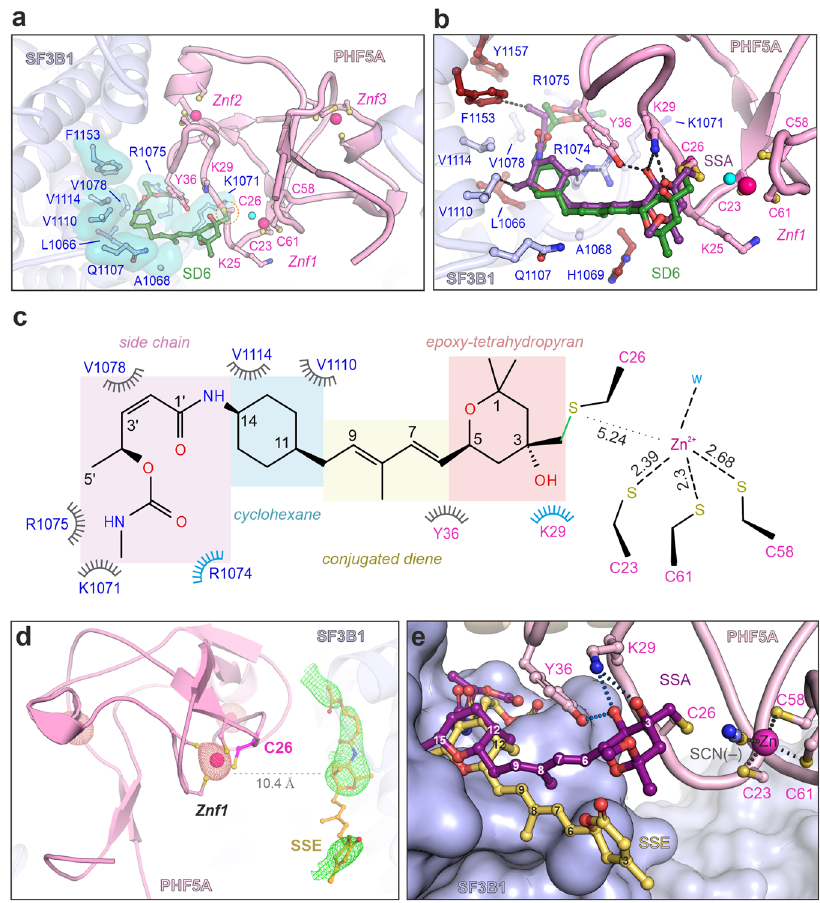
Fig. 3 Crystal structures of SF3B in complex with SD6 and SSE. a Crystal structure shows that SD6 binds covalently to PHF5A and is engaged in contacts with fewer residues than those binding SSA (depicted and labeled). The water molecule and zinc ions are shown as cyan and magenta spheres, respectively. b Structural comparison between SSA and SD6 in co-crystal structure with the SF3B core. The interactions with chemical groups speci fi c for SSA (i.e., absent from SD6) are shown. c Schematic depiction of the SD6 interaction with residues from the hinged pocket, as observed in the crystal structure. Polar contacts are depicted in blue, whereas the hydrophobic interactions are colored gray. SD6 ’ s functional groups are indicated as boxes. d Crystal structure of SF3B Δ BPB in complex with spliceostatin E (SSE). The polder (5.0 σ ) electron density maps are displayed around SSE. An anomalous difference map (dark red, 6.0 σ ) is contoured around PHF5A ’ s three zinc ions. Note the presence of ligand density in the SF3B1-PHF5A tunnel corresponding to the distal half of SSE. In contrast, density for the proximal moiety is largely absent, likely because of its fl exibility in the absence of covalent coupling to C26-PHF5A. e Structural comparison between SSA and SSE in co-crystal structure with the SF3B core. Note that electron density was observed for the distal moiety of SSE, while the proximal moiety (C1 – C10) is likely mobile. The depicted model is based on stereochemistry and space availability in the